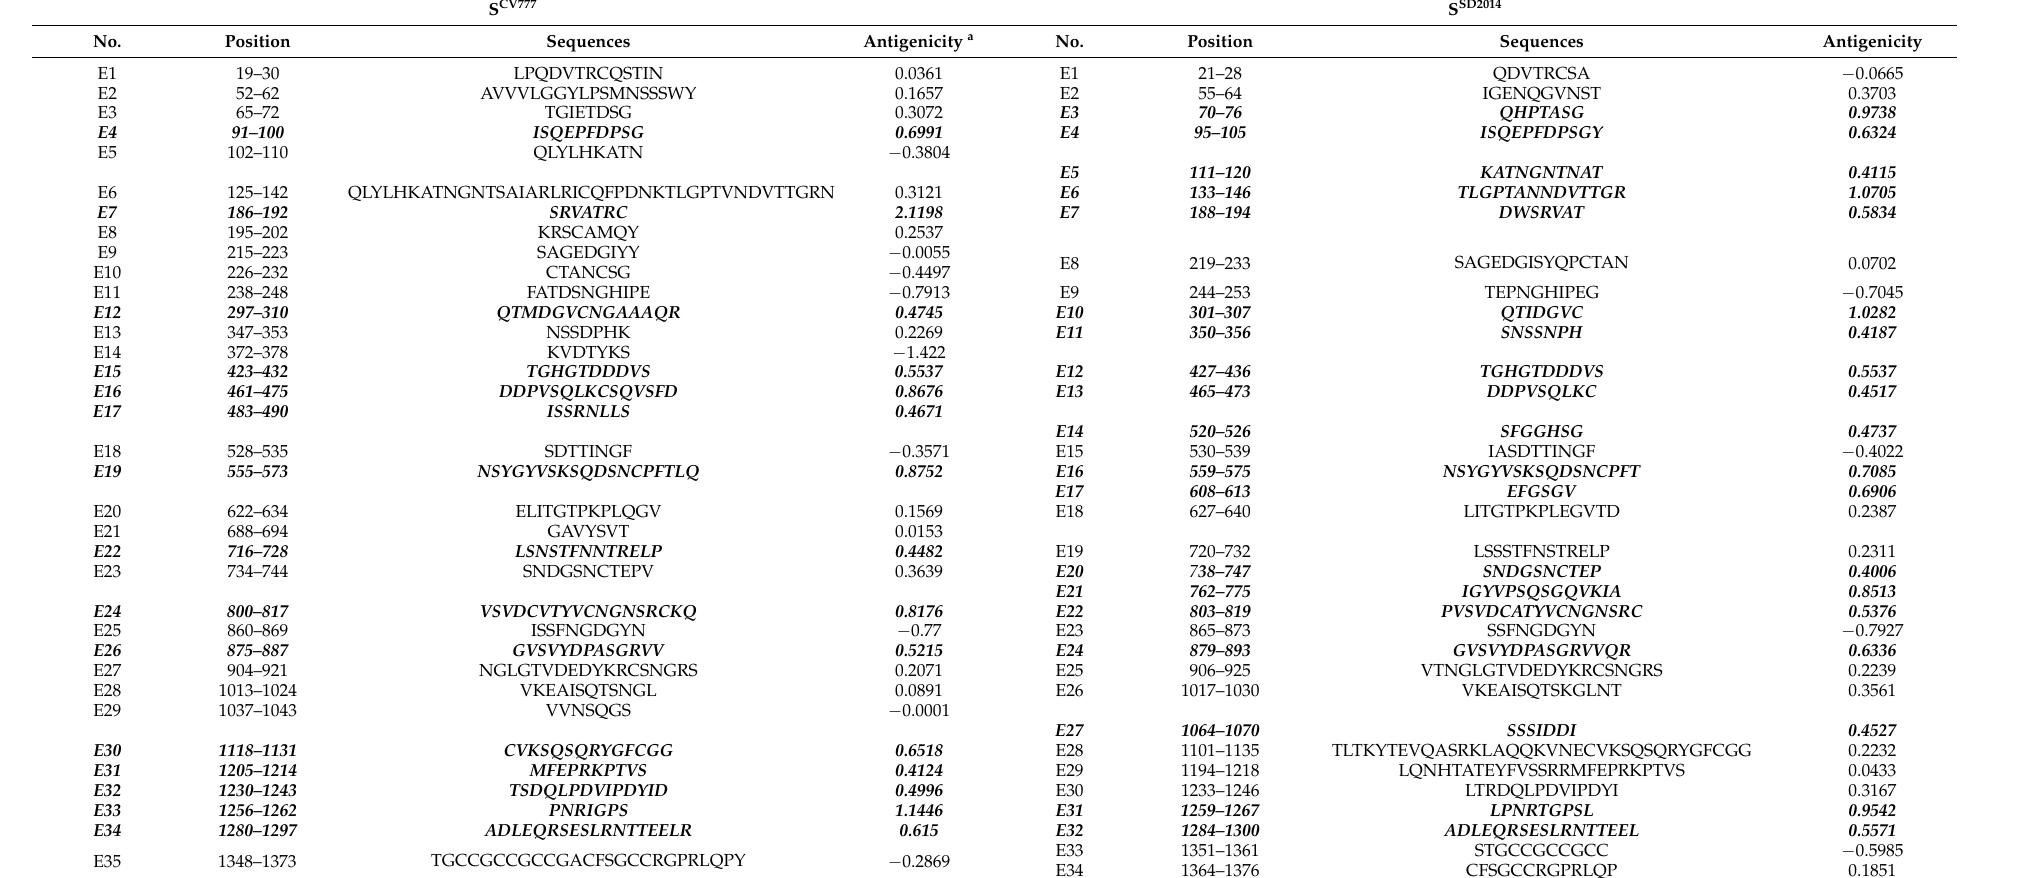
Table 1. Predicted epitopes on S protein of PEDV CV777 (S CV777 ) and that of PEDV SD2014 (S SD2014